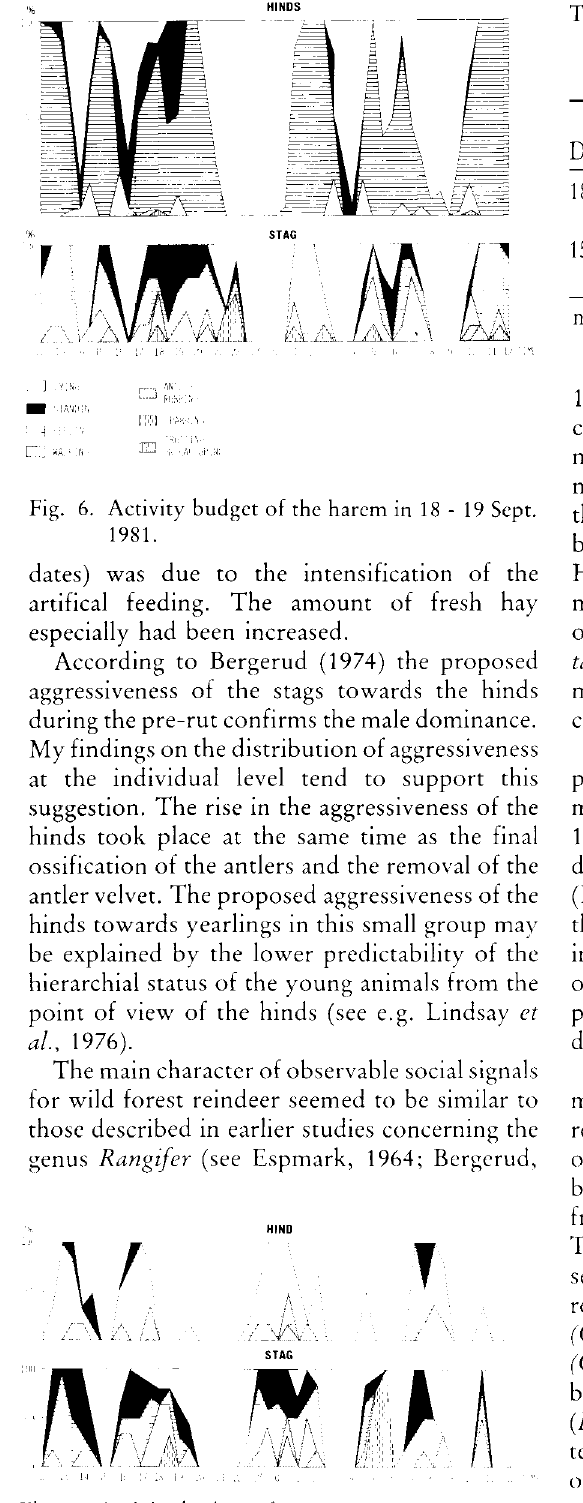
Fig. 7. Activity budget of one unmated hind and the dominant stag in 15 - 16 Oct. 1981.